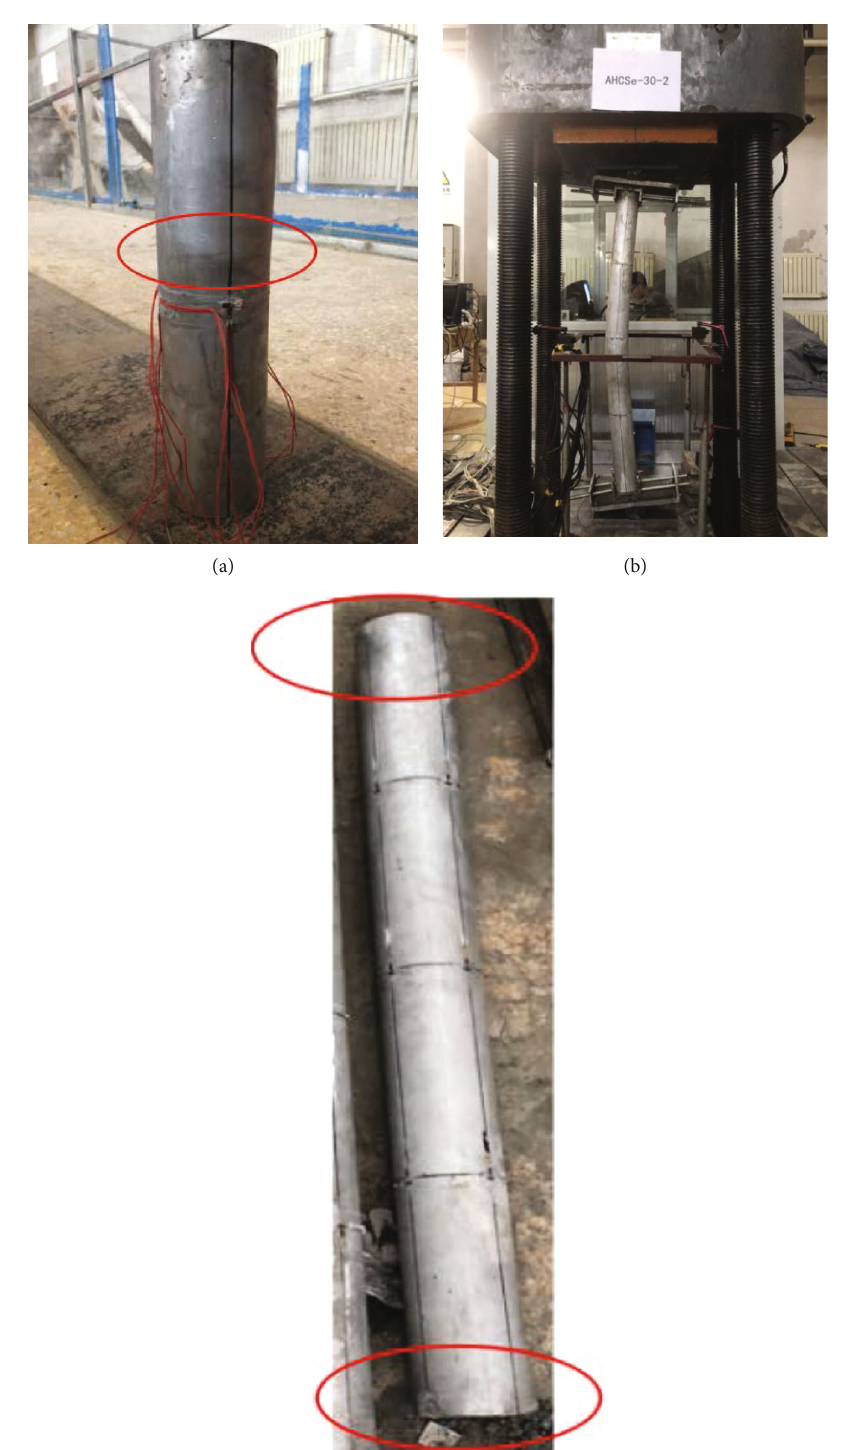
Figure 3: Failure pattern of aluminum alloy concrete columns: (a) central swelling failure; (b) midspan bend; (c) end